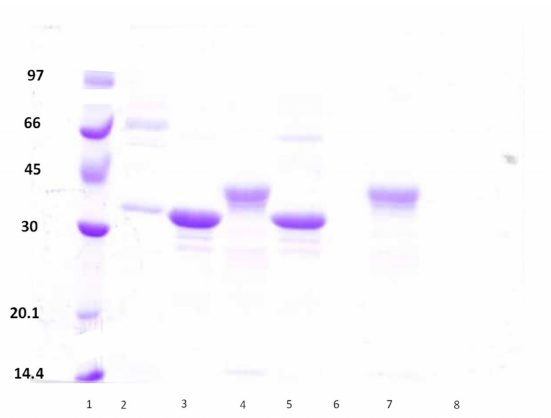
Figure 8. SDS-page analysis of combi-biocatalysts PFL-RML / PFL-LU. Lane 1: molecular weight marker, Lane 2: octyl-PFL; Lane 3: octyl-RML; Lane 4: octyl-LU; Lane 5: COMBI-PFL-RML; Lane 6: COMBI-PFL-RML washed with triton 4%; Lane 7: COMBI-PFL-LU; and Lane 9: COMBI-PFL-LU washed with triton 4%. Experiments were performed as described in